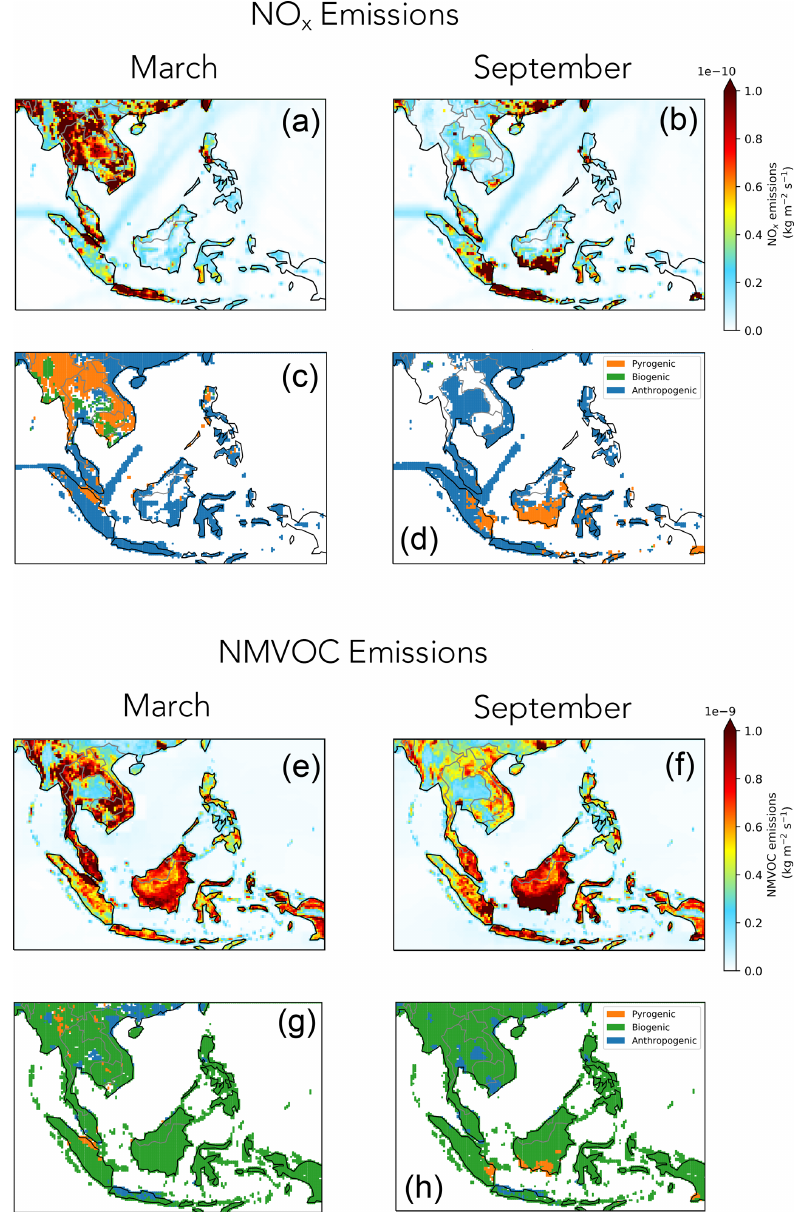
Figure 4. Monthly mean emissions (kgm − 2 s − 1 ) of NO x and NMVOCs across Southeast Asia in March and September 2014. (a, b, e, f) Spatial distribution of emissions. (c, d, g, h) Map of the predominant emission source types: anthropogenic, biogenic or